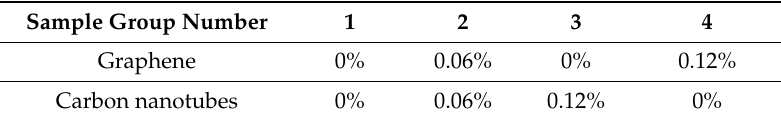
Table 1. The composition of the test